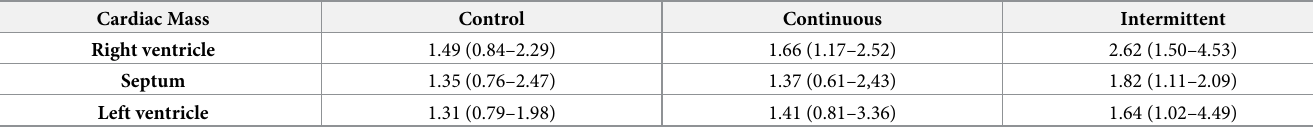
Table 5. Percent area fraction of VEGF in the control, continuous, and intermittent groups.